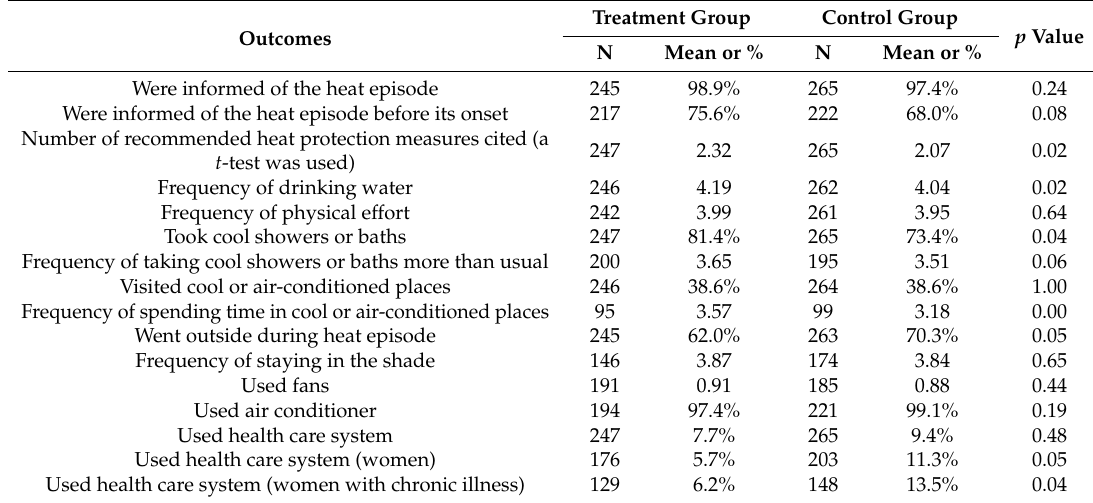
Table 4. Ex post comparison between treatment and control groups regarding outcome variables.